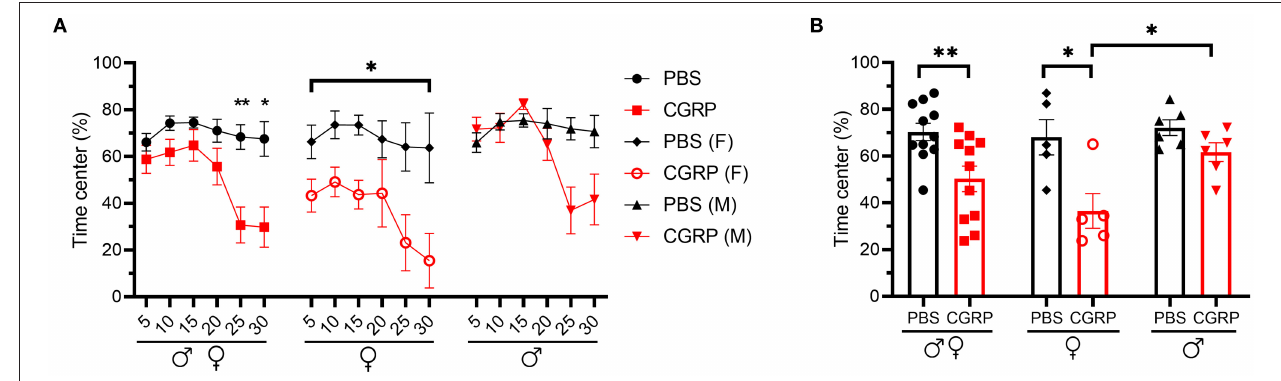
FIGURE 4 | Injection of CGRP into the MN induced anxiety-like behavior in the open field assay. (A) Percentage of time spent in the center of the open field every 5-min block during 30-min testing period following injection of PBS ( n = 11; F: n = 5; M: n = 6) or CGRP (1 µ g/200 nl; n = 11; F: n = 5; M: n = 6) into the right MN of C57BL/6J mice via cannulas. All mice (left) separated by sex (female: middle; male: right). Data are from two independent experiments. All mice in A are further analyzed in B. (B) Mean percentage of time in the center per 5-min block for individual mice. Data are the mean ± SEM. Statistics are described in Supplementary Table 1 . * p ≤ 0.05, ** p ≤ 0.01.